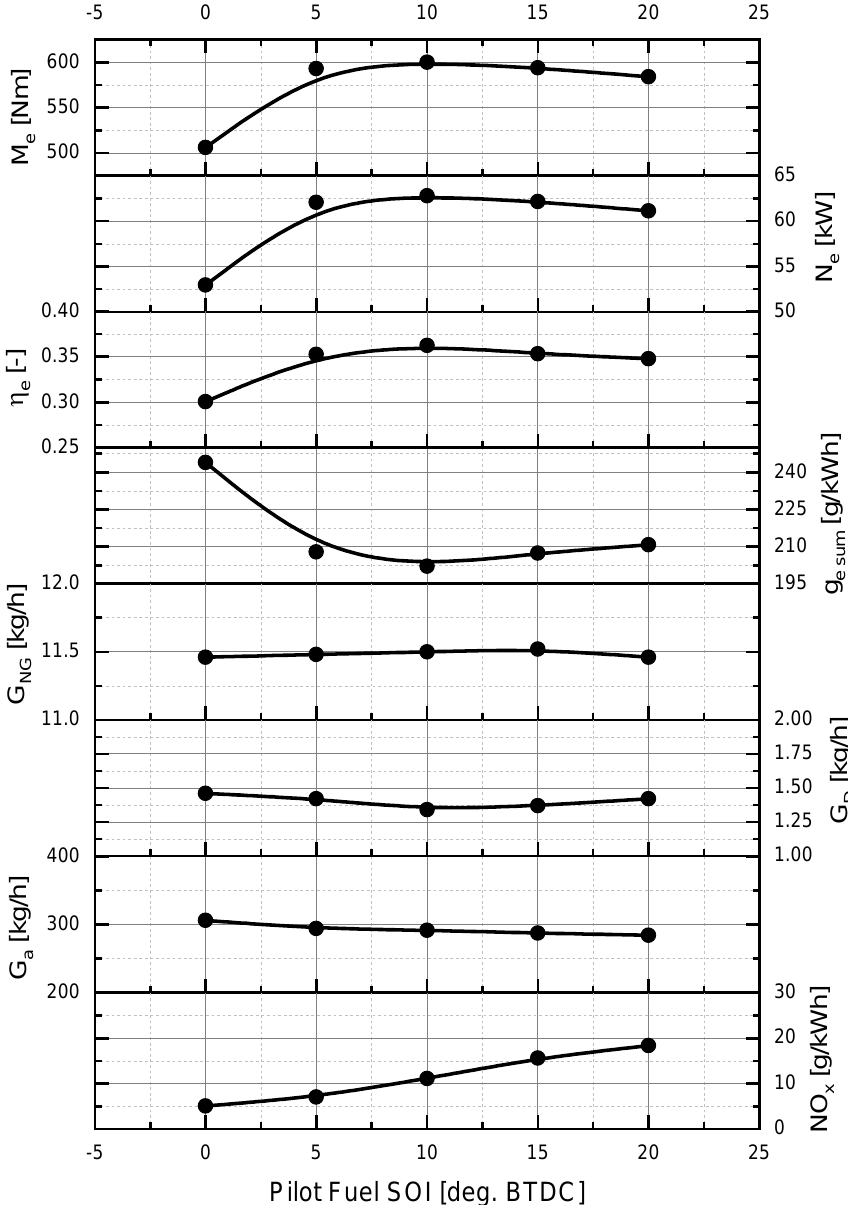
Figure 8. Engine parameters versus pilot fuel start of injection (n = 1000